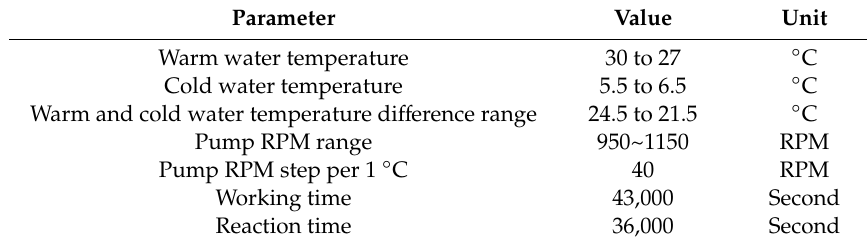
Table 7. Parameters of the dynamic cycle of the